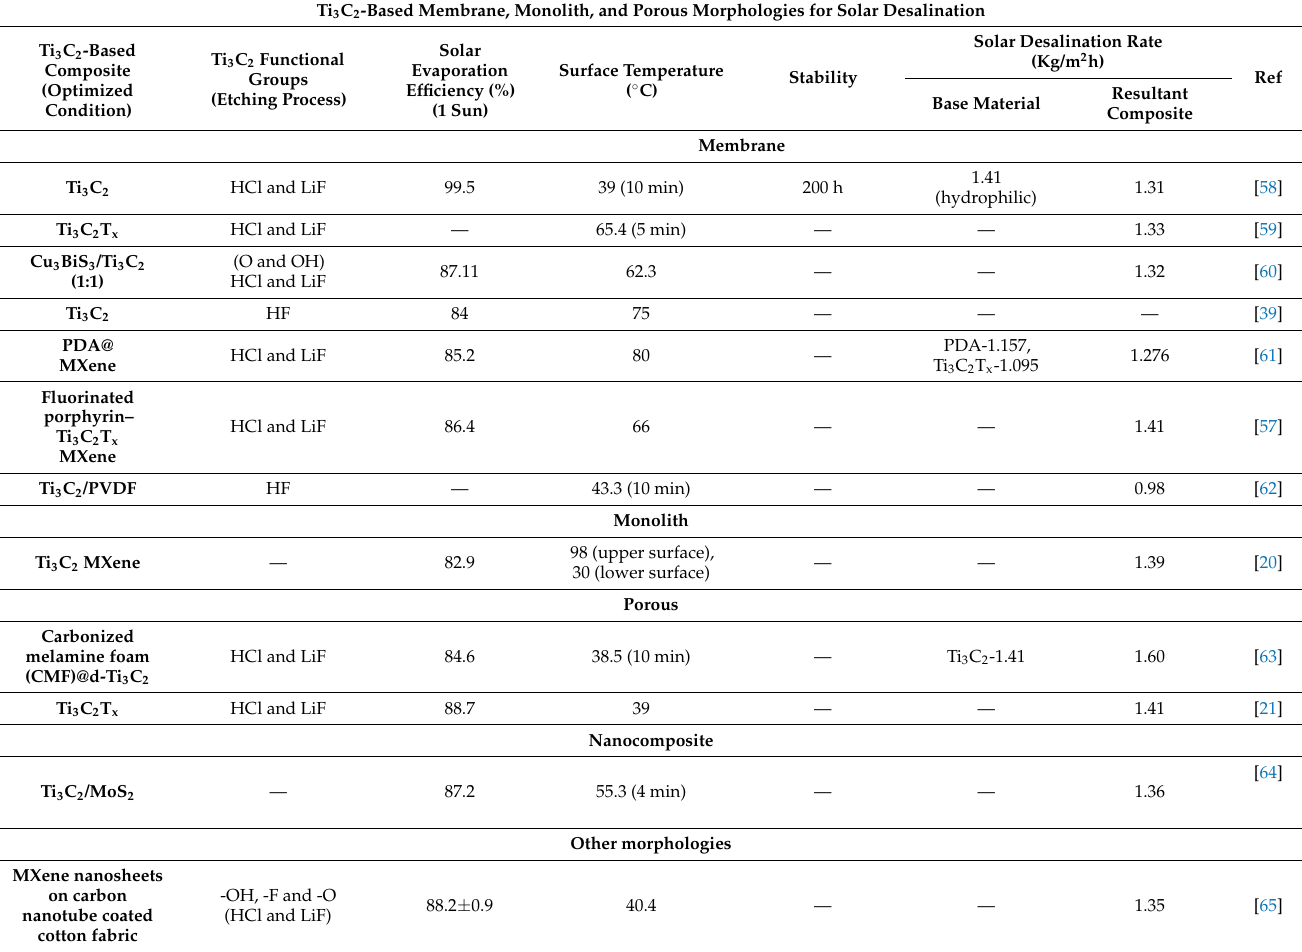
Table 2. Summary of Ti 3 C 2 -based membrane, monolith, and porous morphologies for solar desalination. Ti 3 C 2 -Based Membrane, Monolith, and Porous Morphologies for Solar